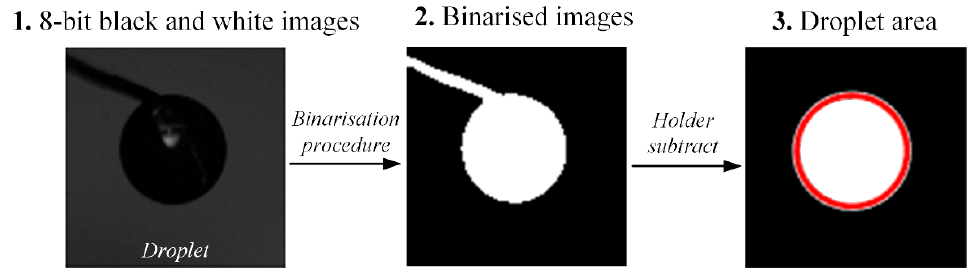
Figure 3. The main steps for postprocessing the sizes and shapes of